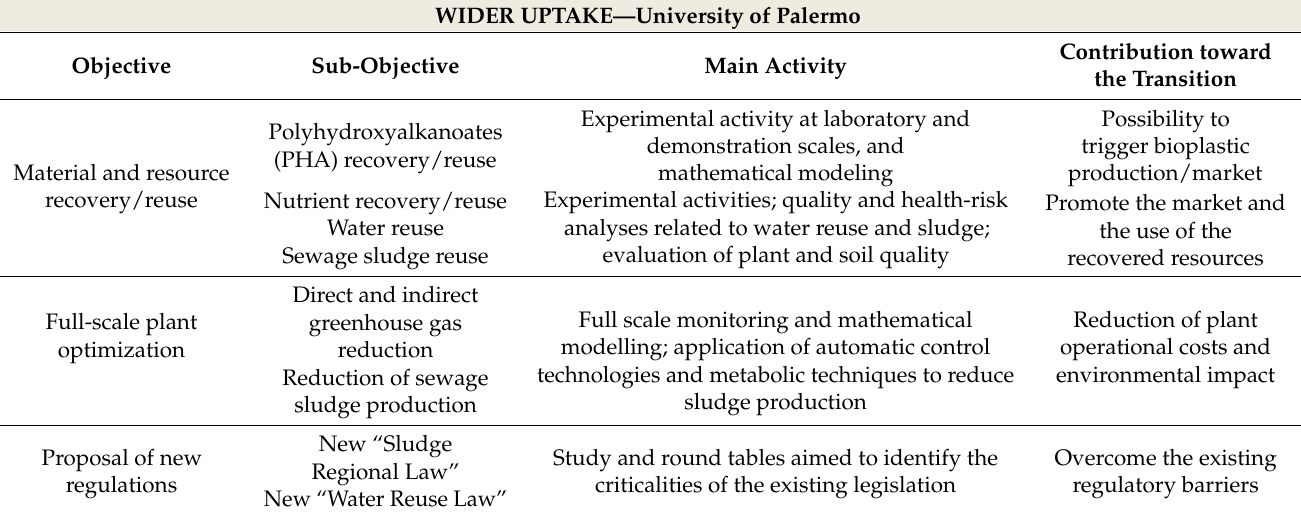
Table 2. Summary of the main objectives and sub-objectives of University of Palermo within the Italian demonstration case in WIDER UPTAKE underlying the main activities and contributions of the transition toward a water-smart